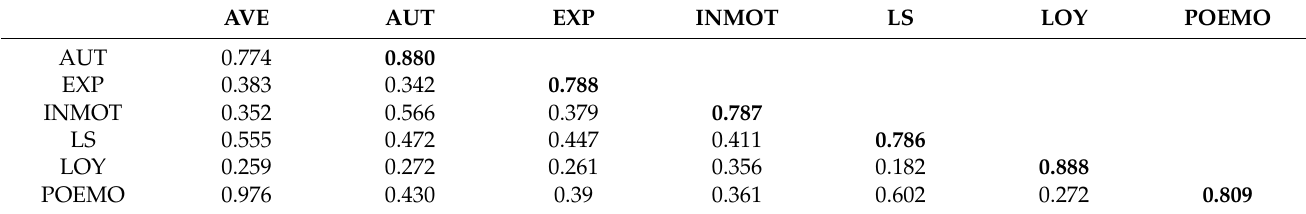
Table 4. Discriminant Validity Results.